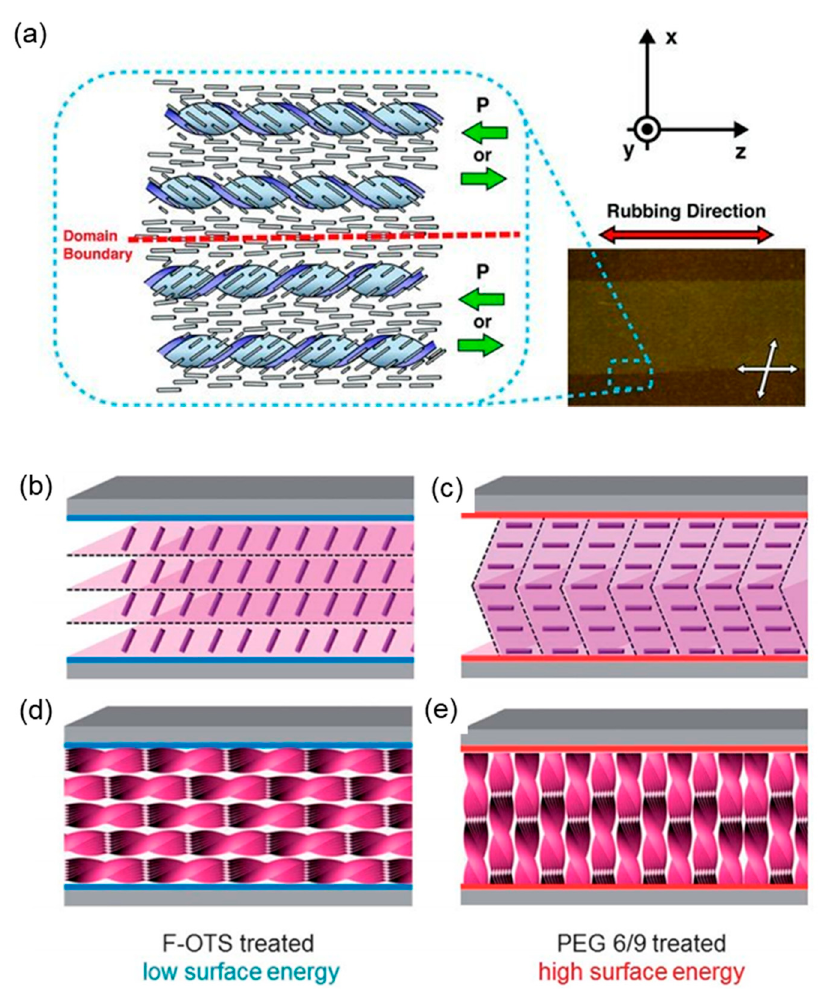
Figure 3. Two examples of the conventional methods to align HNFs. ( a ) When bent-core LC molecules mixed with rod-shaped nematic LC molecules are placed in a rubbed polyimide LC cell, HNFs were grown parallel to the rubbing direction. P represents a direction of polarization in each HNF.